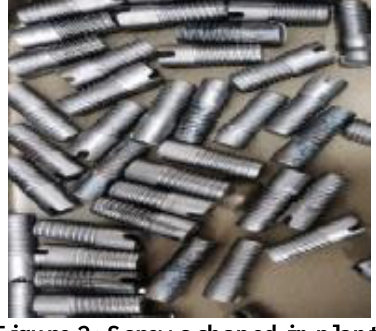
Figure 2: Screws shaped implants Out of the 40 screws, 20 screws were left as machined implants and the remaining 20 screws were coated by electrophoretic deposition process with a mixture of nano zirconium oxide and nano hydroxyapatite (3min., 60V). Coated screws sintered by using carbolite furnace for 820 ºC under inert argon gas to prevent oxidation. Then and kept in airtight sheets till the operation